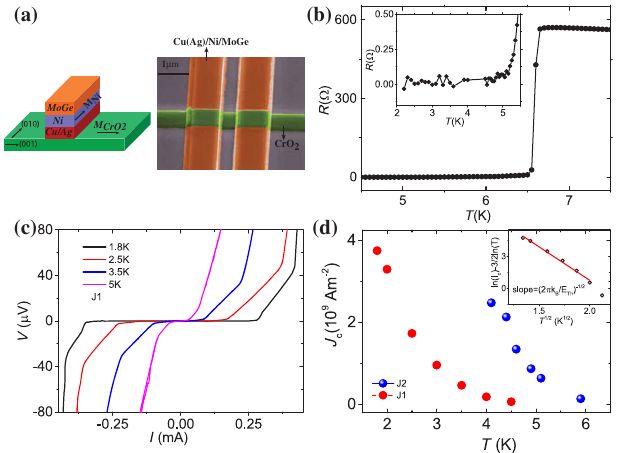
FIG. 4. Josephson junctions with CrO 2 wires. (a) Schematic of Josephson junctions fabricated with CrO 2 wire as a weak link. We show the scanning electron micrograph (false color) of a Josephson junction on a CrO 2 nanowire (green). The graph also shows crystal and magnetization directions. Orange contact pads consist of trilayer (Cu or Ag)/Ni/MoGe. (b) Resistance R versus temperature T for junction J1. The inset shows the behavior around zero resistance. (c) Current I versus voltage V character- istics of J1 at different temperatures. (d) Critical current density J versus T . The inset shows a linear fit to a plot of c Þ − 3 = 2 ln ð T Þ vs T 1 = 2 . ln ð I c